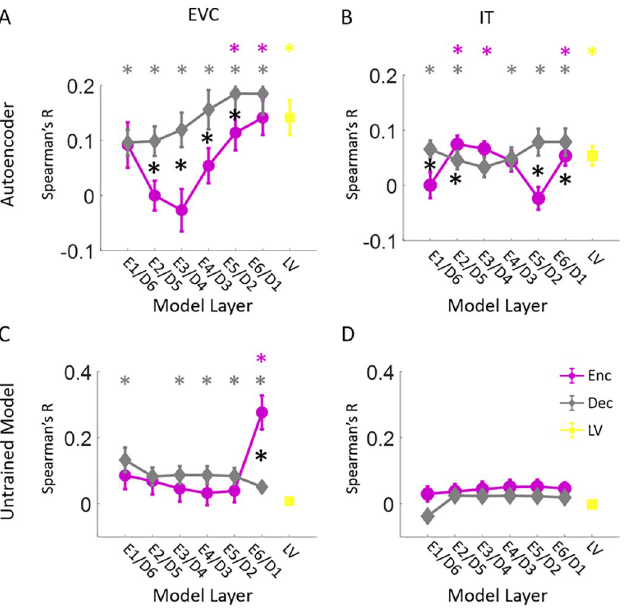
Fig 8. The impact of architecture and training procedure on the representational similarity of the model and brain spatial data. (A) Encoder, decoder and LV layer RDMs of the autoencoder model are correlated (Spearman’s R) with subject-specific EVC RDMs. The averaged correlations over subjects with standard error of the mean are depicted. (B) Encoder, decoder and LV layer RDMs of the autoencoder model are correlated (Spearman’s R) with subject-specific IT RDMs. The averaged correlations over subjects with standard error of the mean are depicted. (C) Encoder, decoder and LV layer RDMs of the untrained model are correlated (Spearman’s R) with subject-specific EVC RDMs. The averaged correlations over subjects with standard error of the mean are depicted. (D) Encoder, decoder and LV layer RDMs of the untrained model are correlated (Spearman’s R) with subject-specific IT RDMs. The averaged correlations over subjects with standard error of the mean are depicted. The color coded ( � ) above each panel in C-D indicates that the correlation of the corresponding layer is significantly above zero. The black ( � ) indicates the correlations of the corresponding encoder and decoder layers are significantly different (N = 15; two-sided ttests; false discovery rate corrected at P < 0.05).